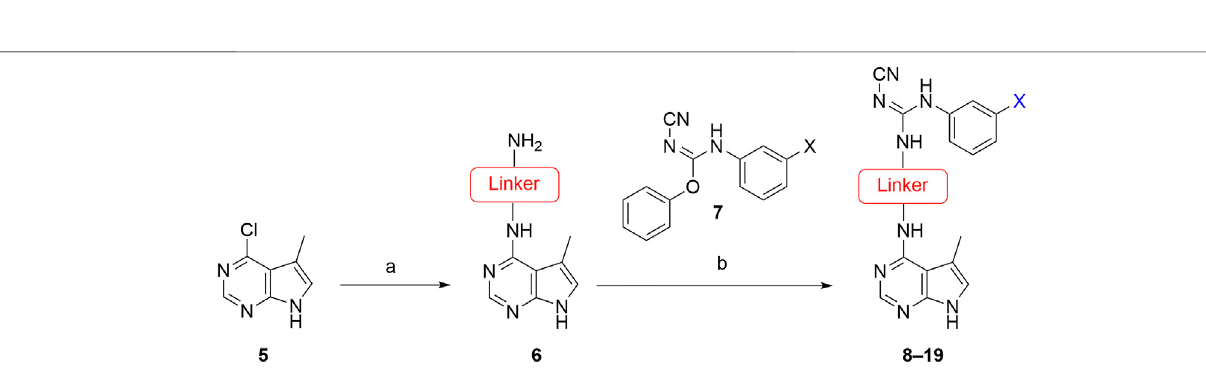
Frontiers in Chemistry |